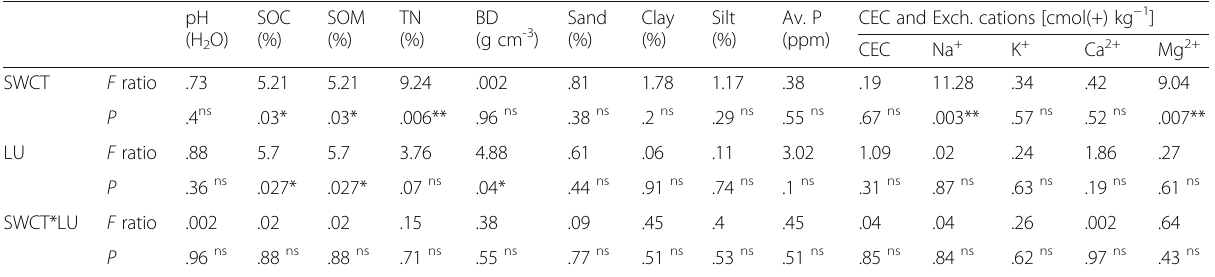
Table 6 The two-way ANOVA result showing the interacton effect of land uses and SWC treatment on soil physicochemical properties